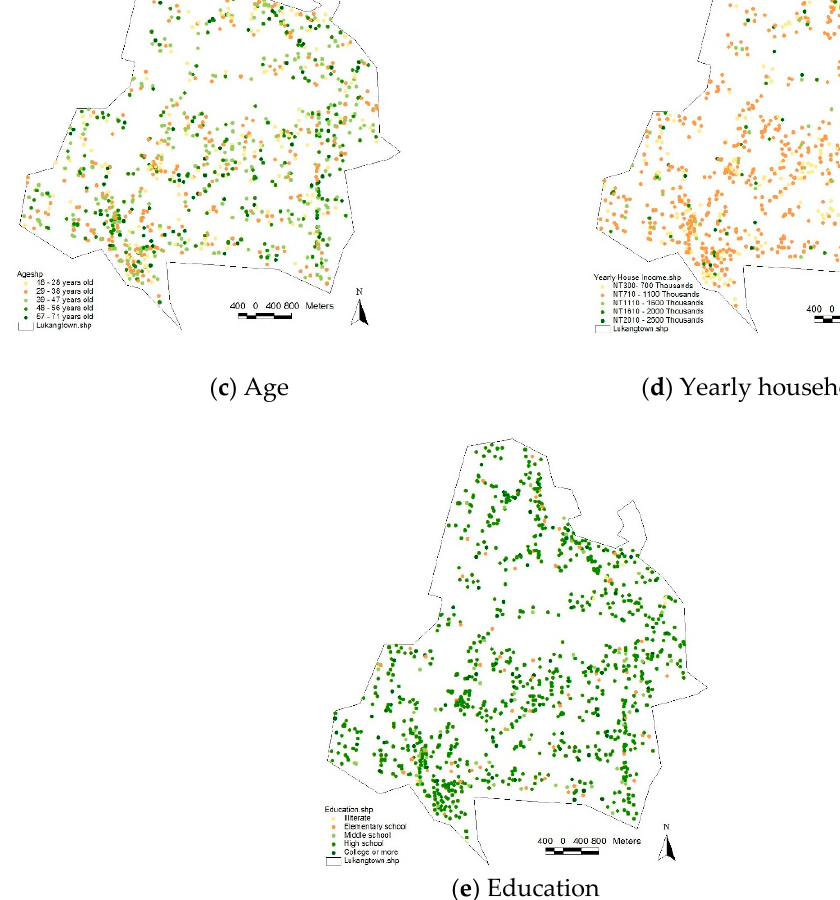
Figure 3. The choropleth maps of personal benefits from tourism, gender, age, yearly household income, and education.